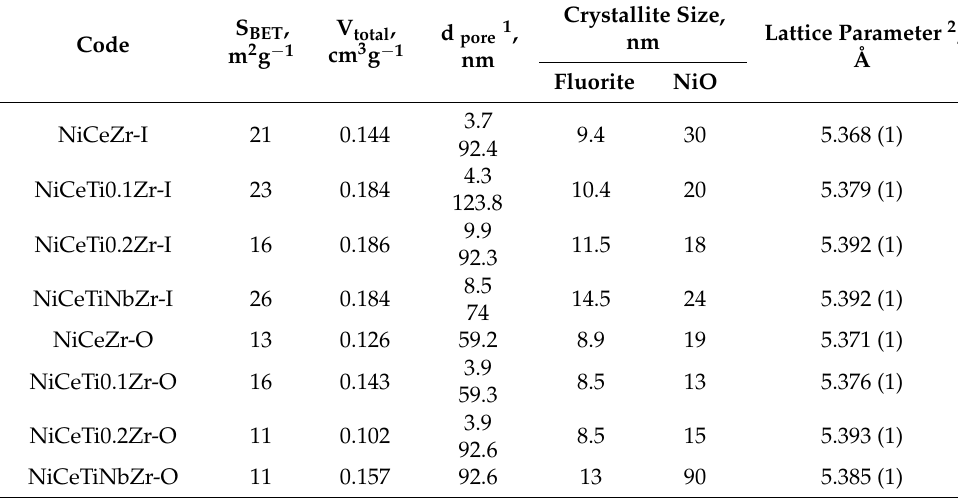
Table 2. Textural and structural properties of prepared